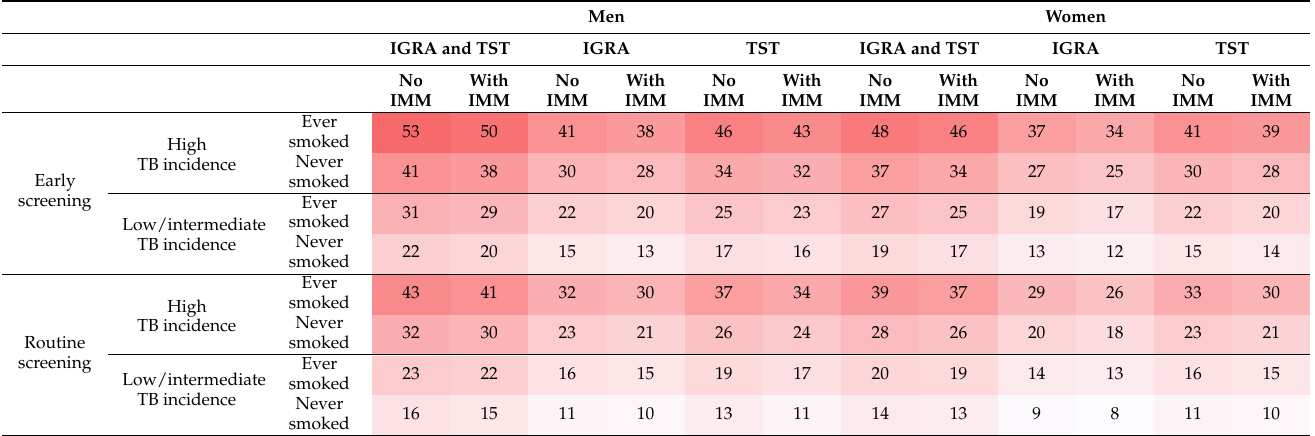
Table 5. Probability (%) of LTBI according to gender, smoking status, immunomodulator use at screening, strategy of screening (dual versus single, early versus routine) and origin in a country with a high or intermediate/low incidence of